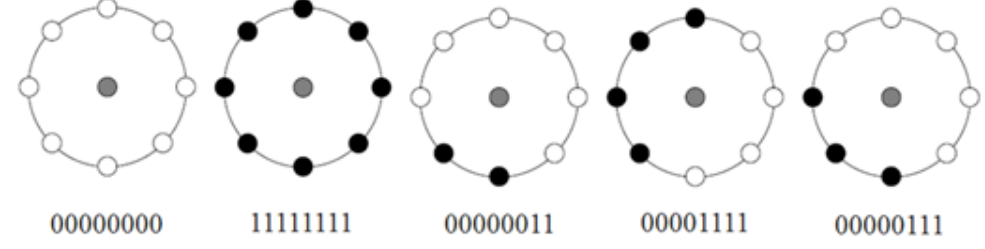
Figure 2. Some results of the modified local binary pattern (MLBP): White and black circles represent zero and one binary patterns, respectively.